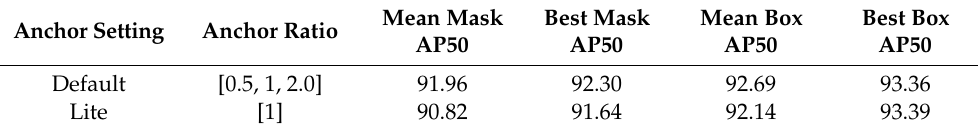
Table 5. Model performances under different anchor settings.